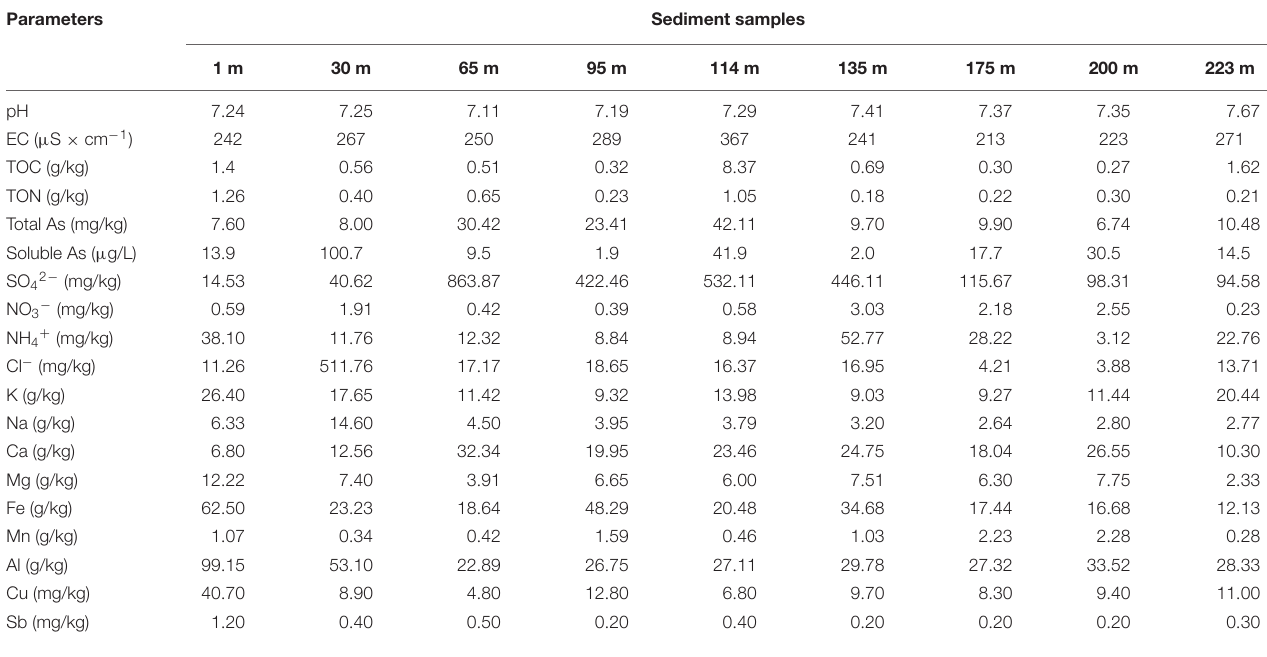
TABLE 2 | Geochemical features of the nine samples from the Jianghan Plain.